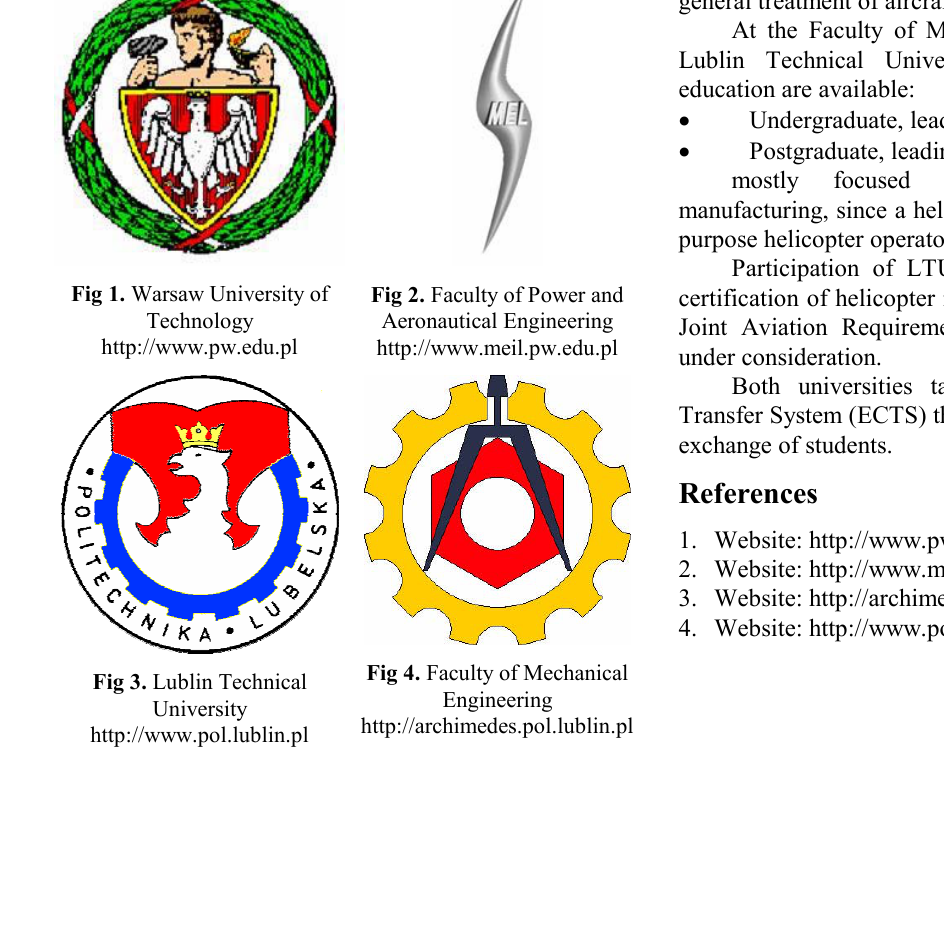
Fig 1. Warsaw University of Technology